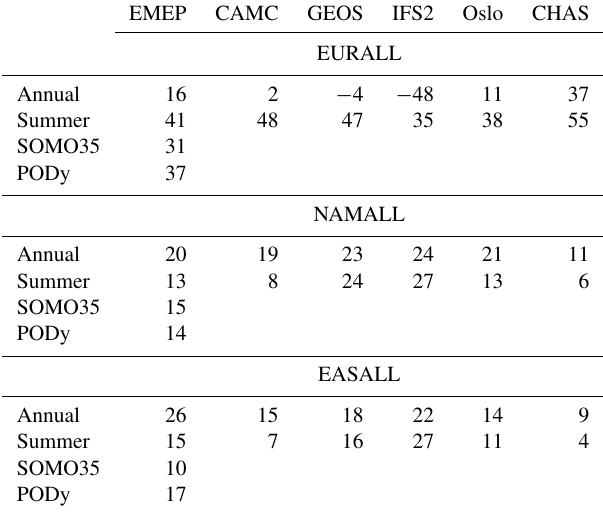
Table 4. Percentage contributions (where BASE–GLOALL repre- sents 100%) to European annual ozone, summer (June, July, Au- gust) ozone, SOMO35 and POD 1 forest (SOMO35 and POD 1 for- est only from the EMEP model) calculated from the 20% reductions of anthropogenic emissions in Europe, North America and eastern Asia. Model EMEP is EMEP_rv48, CAMC is CAMchem, GEOS is GEOS-Chem, IFS2 is IFS_v2, OSLO is OsloCTM3_v2 and CHAS is